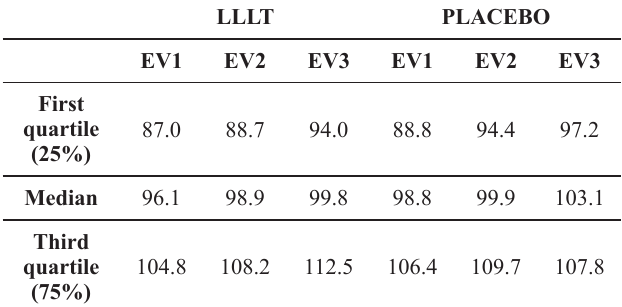
Table 3 - Results observed in the Star Excursion Balance Test (SEBT), the distance is displayed in